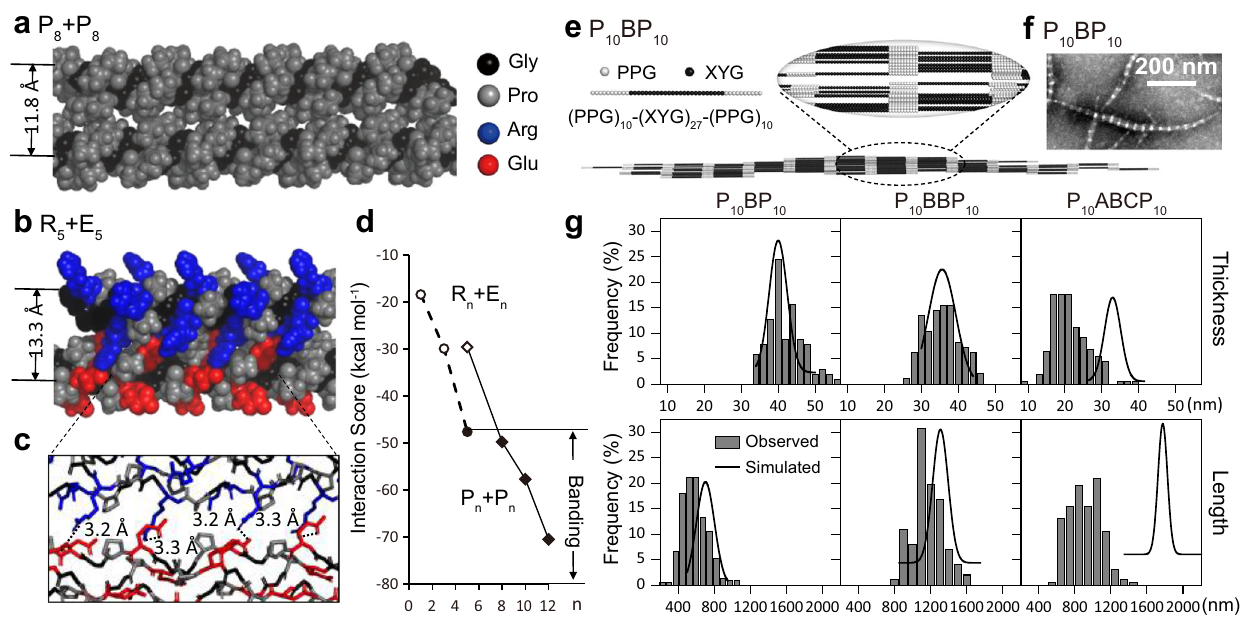
Fig. 4 | Multi-scale computational simulations to understand the assembly mechanism of the banded fi bers. a – d Atomic-level models of the interactions between adhesive modules were built with the software package ProtCAD 29 , with conformations optimized to achieve the lowest interaction score based on simu- lated annealing. Structural models of P 8 +P 8 ( a ) and R 5 +E 5 ( b) , with the lowest interaction scores shown as space- fi lling models. Predicted salt bridges in R 5 +E 5 areshownwithdashedlinesin c .PredictedinteractionscoresofP n +P n (diamonds) and R n +E n (circles) were plotted against the number, n, of the triplets in the adhesivemodulesin d .Filleddatapointsrepresentdesignsforwhichbanded fi bers were observed. e Fiber morphology and dimensions were simulated with a diffusion-limited aggregation simulation 35 . A triple-helical unit, [(Xaa-Yaa-Gly) 1 ] 3 ,